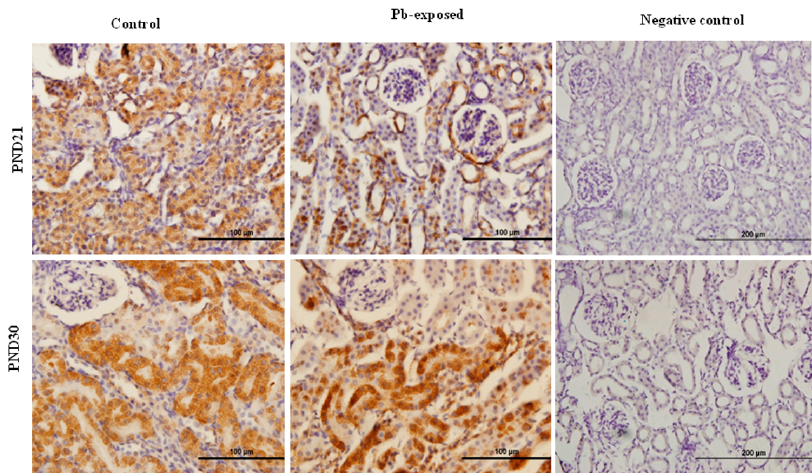
Figure 5. Immunohistochemistry photomicrographs showing the effects of Pb exposure on the expression of 1- α -hydroxylase in kidney of both control and Pb-exposed at PND21 and PND30 rats. Sections ( n = 3) were counterstained with Mayer’s hematoxylin.